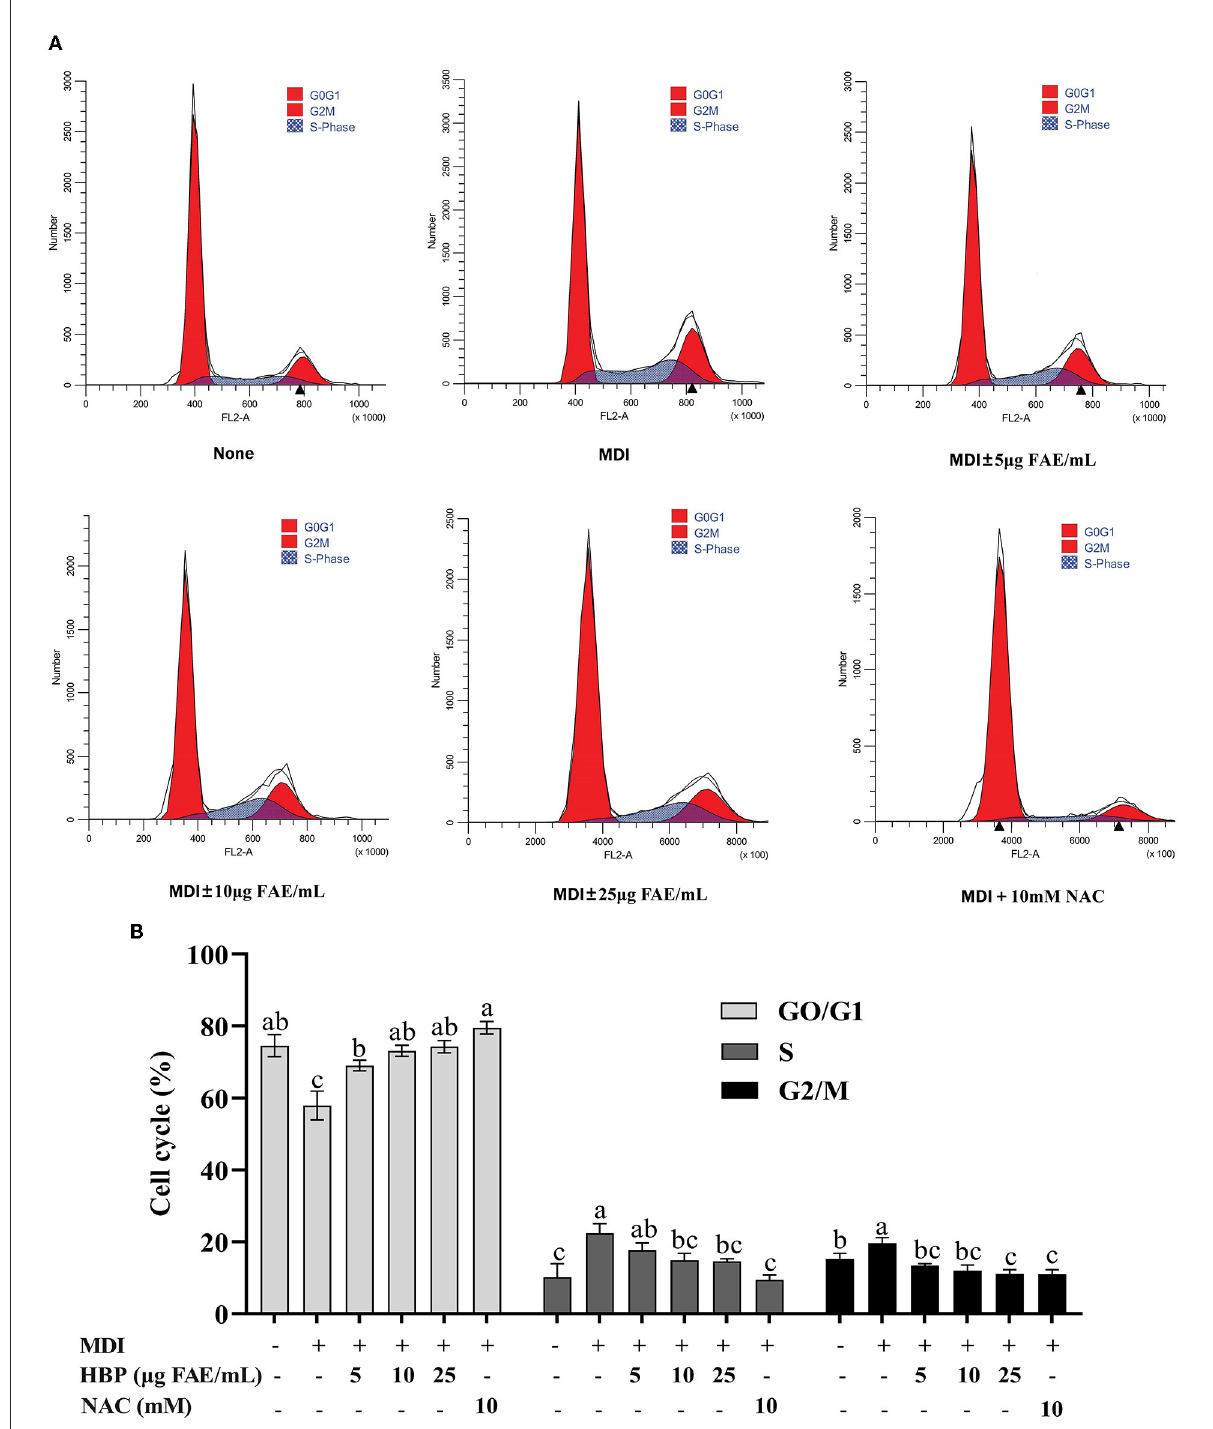
FIGURE4 Regulatory role of HBP extract on cell cycle progression in 3T3-L1 adipocytes. (A) 3T3-L1 preadipocytes were incubated in MDI with or without HBP extract for 24h. The cells were harvested and stained with PI, and then the cell cycle was analyzed using flow cytometry. (B) Quantification of the cell cycle stage distribution. The values were expressed as the mean